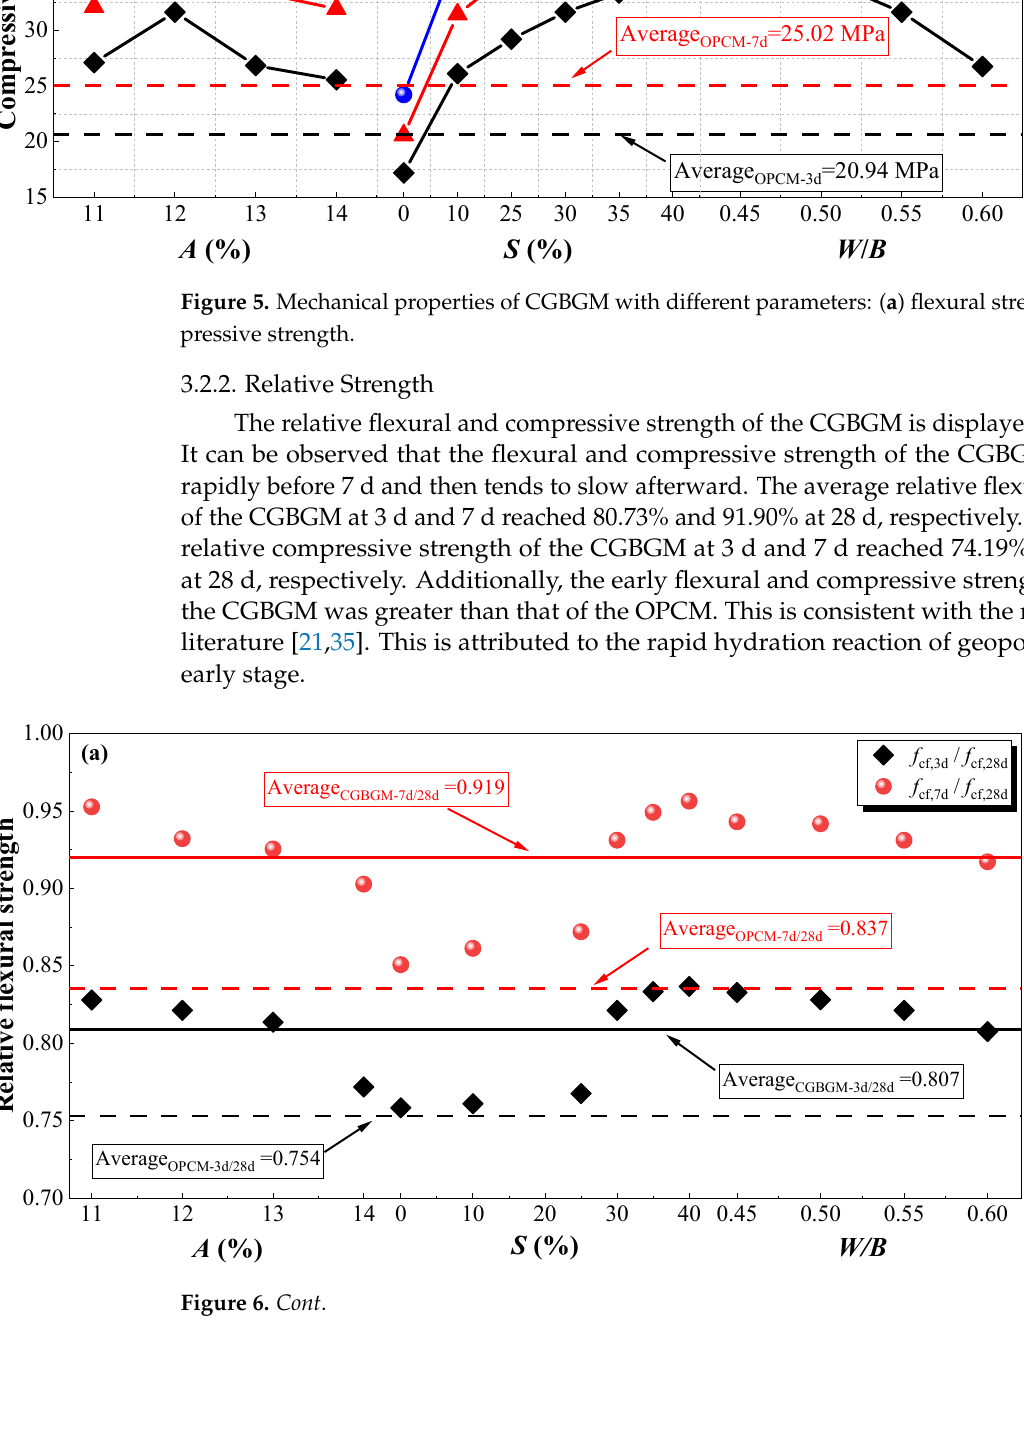
Average OPCM-7d/28d =0.674 Figure 6. Relative strength of the CGBGM: ( a ) relative flexural strength; ( b ) relative compressive strength. 3.2.3. Influence of the f cf /f cu Ratio Figure 7 displays the comparison results of the f cf / f cu ratio of the CGBGM at each cur- ing age. The f cf / f cu ratio gradually declined with increasing curing ages, indicating that the development of the compressive strength at the later stage was superior to that of flexural strength. The effect of the A on the f cf / f cu ratio was opposite to that on the f cf (or f cu ), and the f cf / f cu ratio was the smallest when the A = 12%. The f cf / f cu ratio reached the maximum value when the S = 30%. In addition, the f cf / f cu ratio reached the maximum value when the W / B = 0.50, which was similar to slag content.